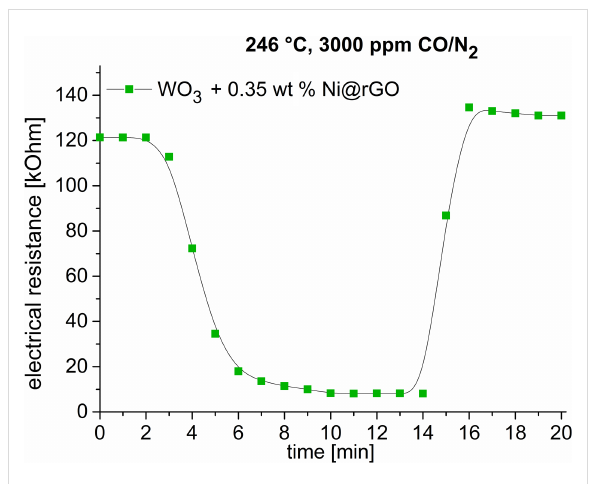
The average size of WO 3 nanoparticle crystallites, calculated from the powder pattern using the Scherrer equation, is 40 nm.